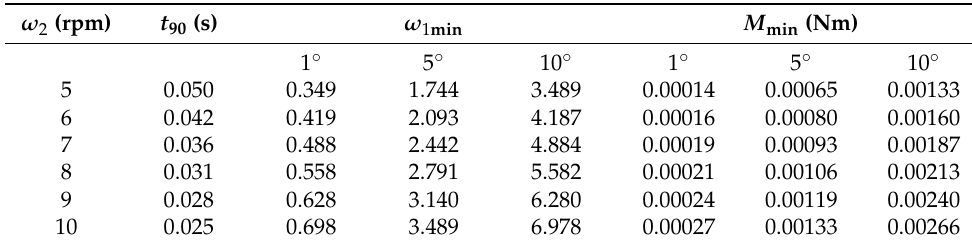
Table 1. Results of numerical